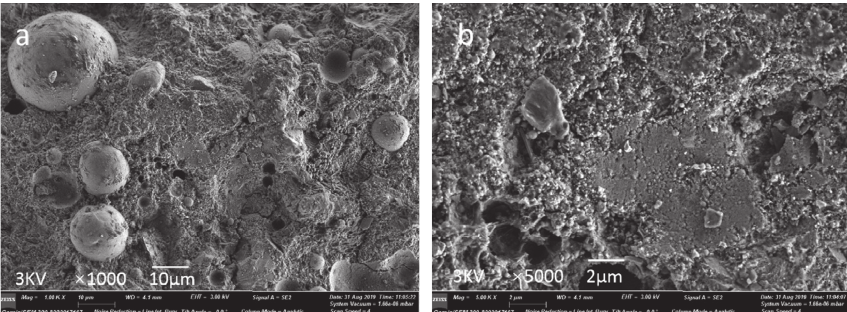
Figure 7: SEM micrographs showing the morphology specimen b5 at 1000x (a) and 5000x (b)